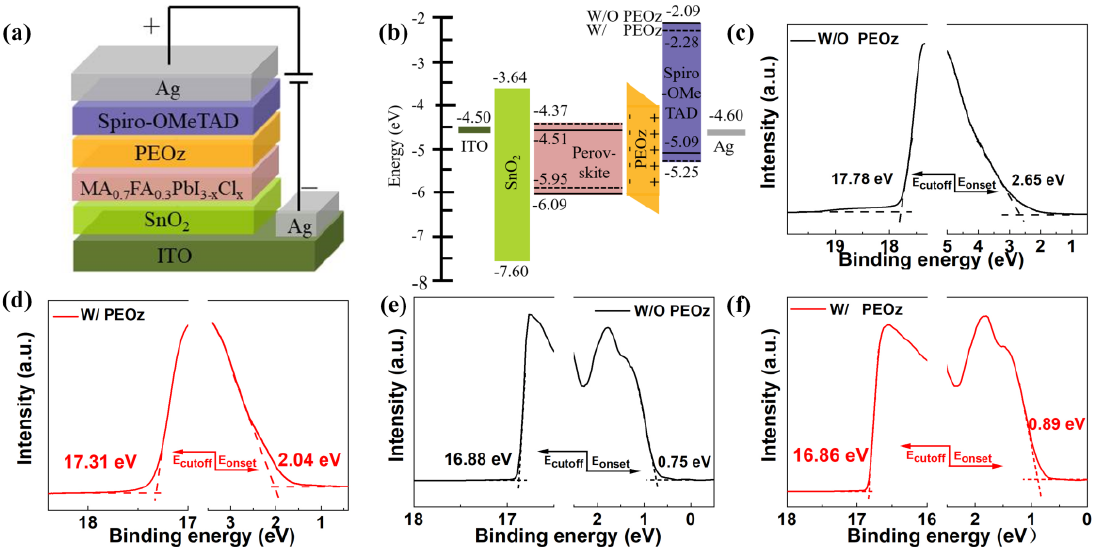
Figure 4. ( a ) Schematic device structure and ( b ) energy band diagrams of corresponding materials used in the PSCs (ITO/SnO 2 /perovskite/PEOz/spiro − OMeTAD/Ag). ( c ) UPS spectra of the perovskite film without and ( d ) with PEOz passivation, ( e ) Spiro − OMeTAD thin film without and ( f ) with PEOz passivation show the VBM onset (E onset ) and photoemission cut − off energy boundary (E cutoff ) values.